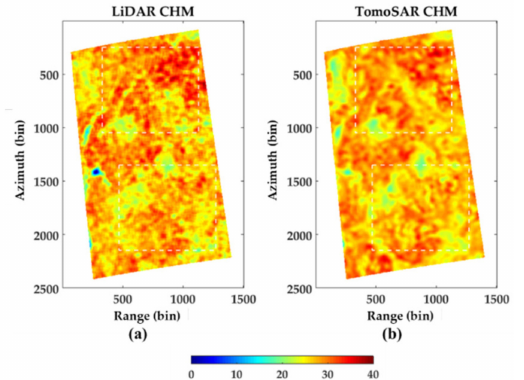
Figure 8. The CHM estimated by the SKP-IMLE method: ( a ) LiDAR CHM; ( b ) TomoSAR CHM. The white dotted areas are the estimated CHM and LiDAR CHM of the two